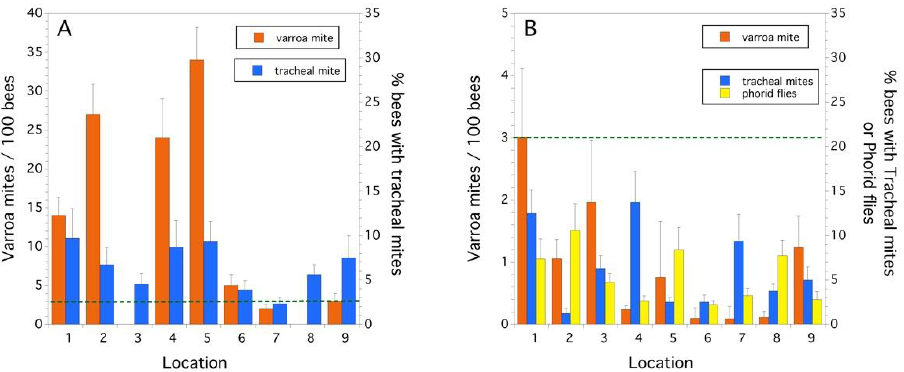
2014 ( B ), trapped pollen in 2015 ( C ), wax comb in 2015 ( D ), and bee bread in 2015 ( E ).